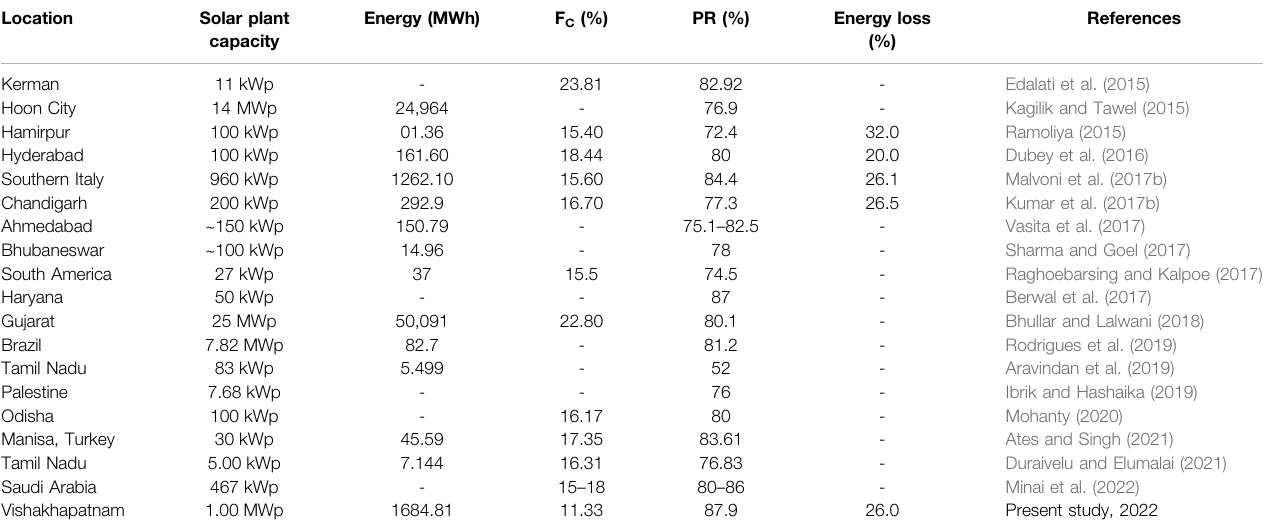
TABLE 1 | Performance correlation with existing roof-top PV